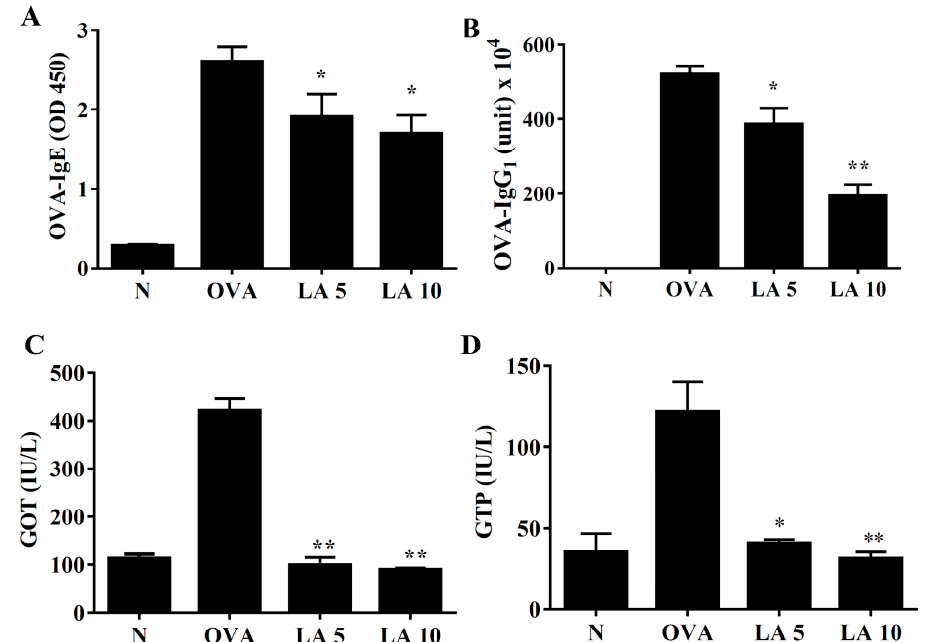
Figure 8. E ff ects of licochalcone A (LA) on OVA-specific antibodies in serum. ( A ) Serum levels of OVA-IgE and ( B ) OVA-IgG1 in normal (N) and OVA-stimulated (OVA) mice with or without licochalcone A (LA5-10) treatment. ( C ) E ff ects of LA on the serum biochemical value, including glutamate oxaloacetate transaminase (GOT) and ( D ) glutamic pyruvic transaminase (GPT). Three independent experiments were analyzed, and data were presented as mean ± SEM. * P < 0.05 compared to the OVA control group. ** P < 0.01 compared to the OVA control